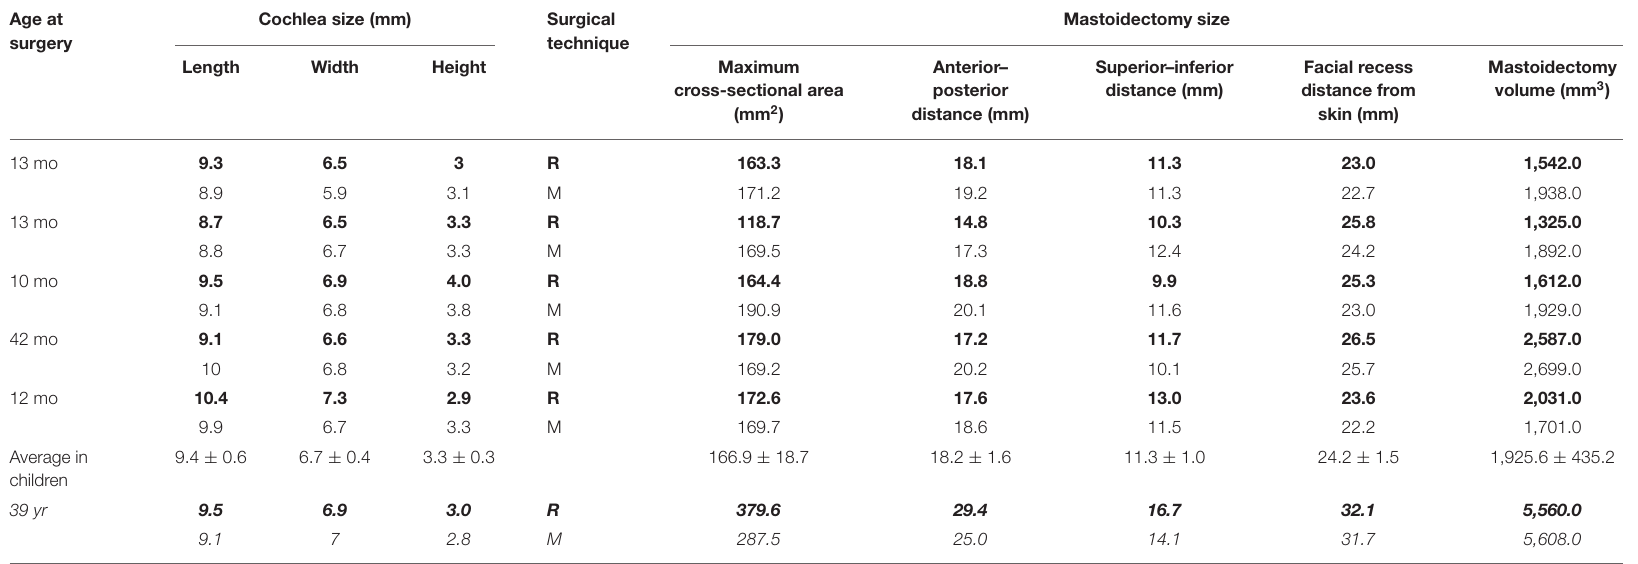
TABLE 2 | Anatomic parameters of cochlea and mastoidectomy in infant and adult recipients. Age at Cochlea size (mm) Surgical surgery Length Width Height Maximum